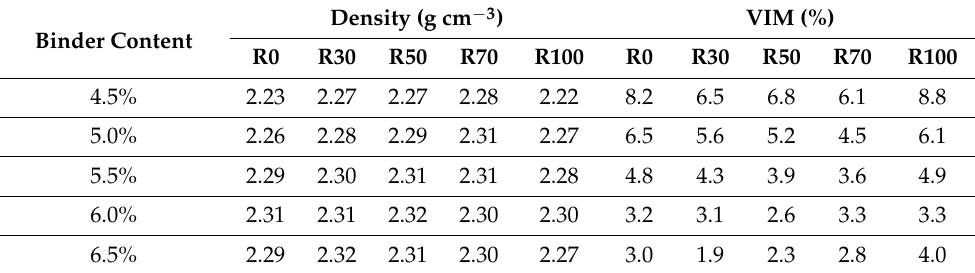
Table A2. Density and VIM result in various binder contents. Binder